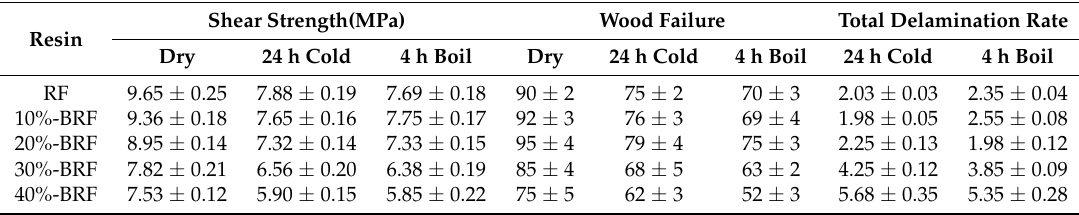
Table 2. Bonding performances of the RF and BRF